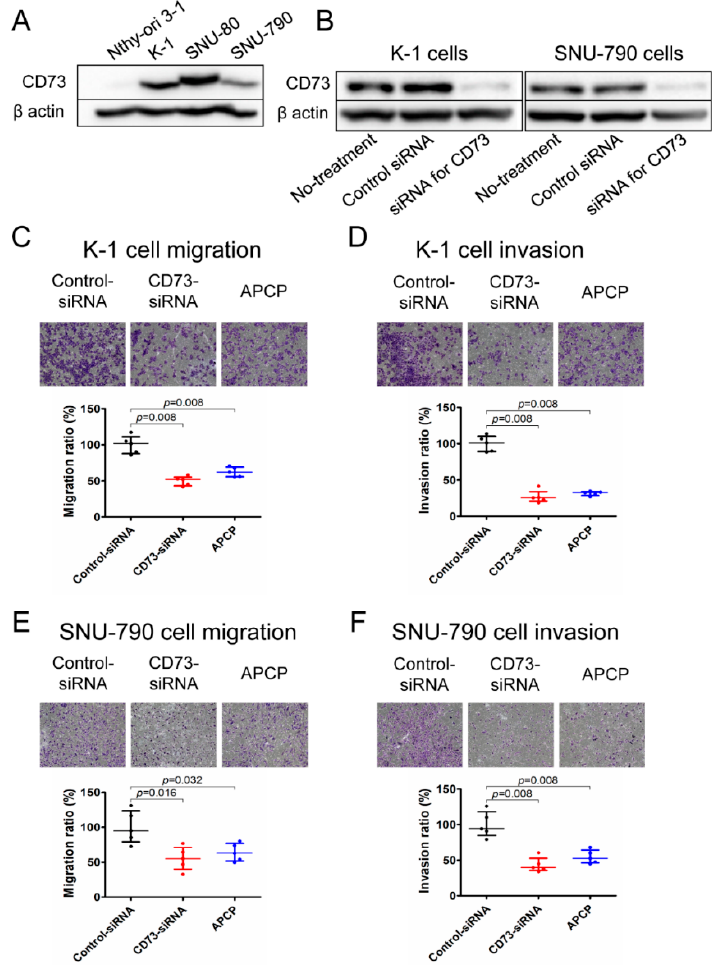
Figure 3. Western blot analysis of CD73 expression and transwell migration and invasion assays in thyroid cell lines. ( A ) Absence of CD73 expression in normal thyroid (Nthy ‐ ori 3 ‐ 1) and high expression of CD73 in papillary thyroid carcinoma (K ‐ 1 and SNU ‐ 790) and anaplastic thyroid carcinoma (SNU ‐ 80) cell lines. Densitometry data generated for Western blots are shown in Figure S1. ( B ) Inhibition of CD73 expression by siRNA in K ‐ 1 and SNU ‐ 790 cells. Inhibition of CD73 expression by the administration of CD73 ‐ siRNA and specific CD73 inhibitor, adenosine 5 ′‐ ( α , β‐ methylene) diphosphate (APCP), downregulates migration and invasion of K ‐ 1 ( C , D ) and SNU ‐ 790 ( E , F ) cells.